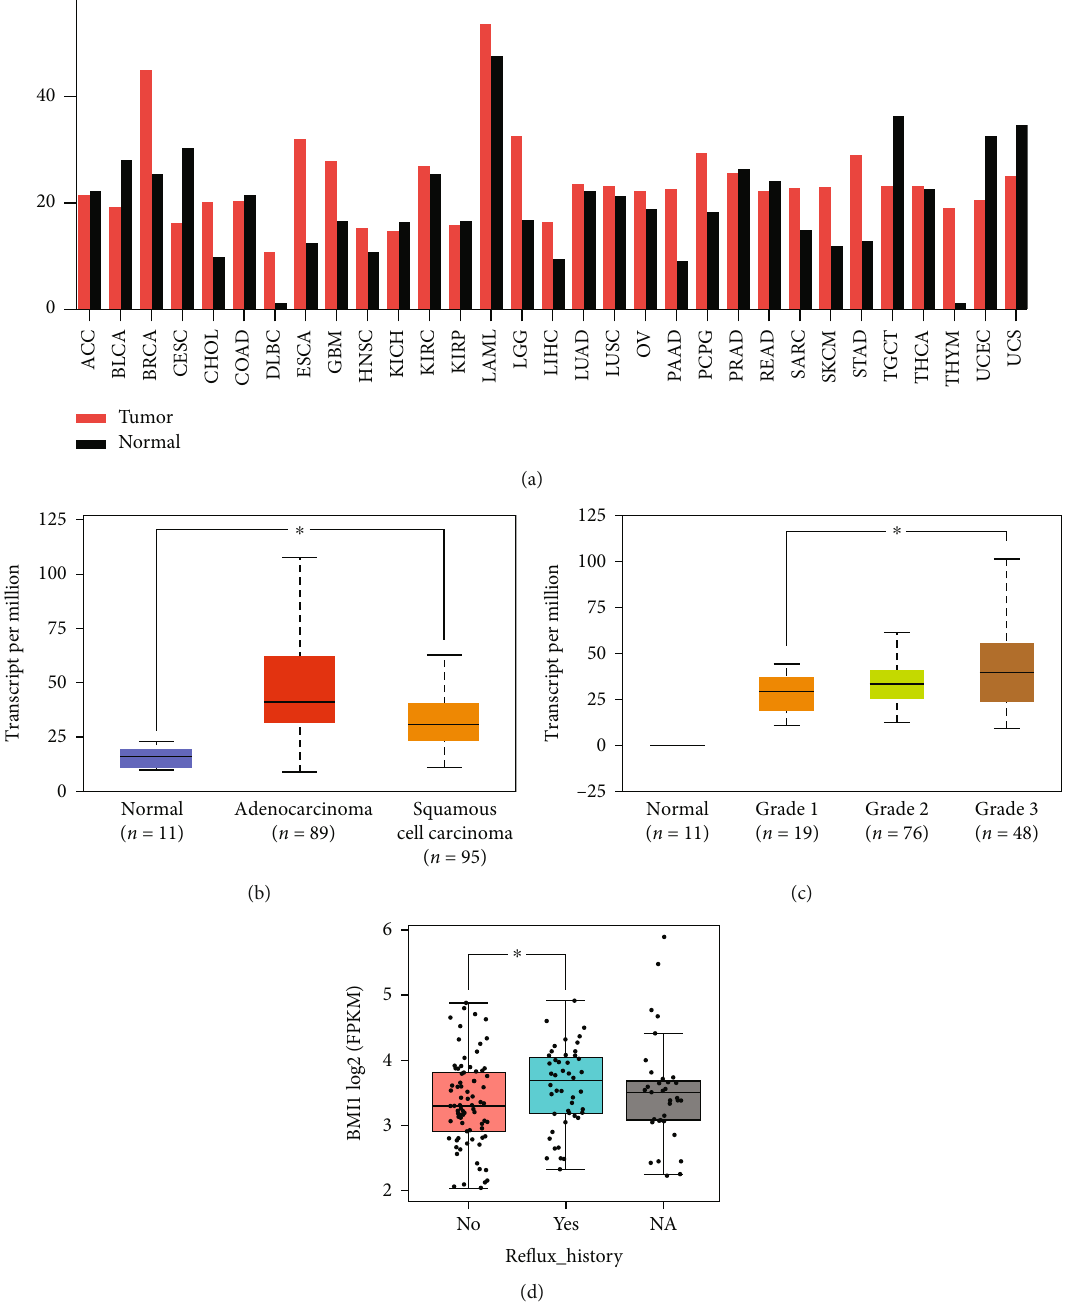
Figure 1: High expression of Bmi1 in esophageal carcinoma. (a) The TCGA database demonstrated that Bmi1 gene expression was signi fi cantly upregulated in esophageal carcinoma tissues. (b) Bmi1 expression levels in ESCA based on tumor histology were compared with normal tissues in the TCGA database ( n = 195 ). (c) Bmi1 expression levels in di ff erent grades of esophageal carcinoma from TCGA database. (d) Gastroesophageal re fl ux is more likely to occur in patients with high expression of Bmi1. No = patients without gastroesophageal re fl ux; Yes = patients with gastroesophageal re fl ux; NA = data missing. ∗ p < 0 : 05